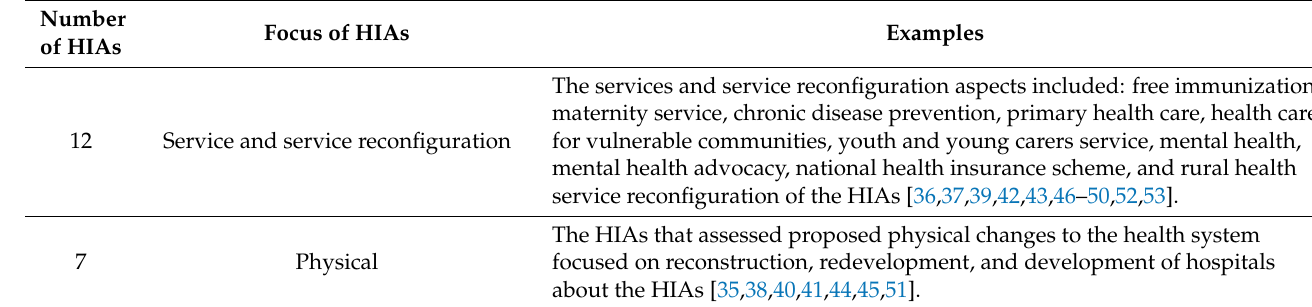
Table 3. Focus of